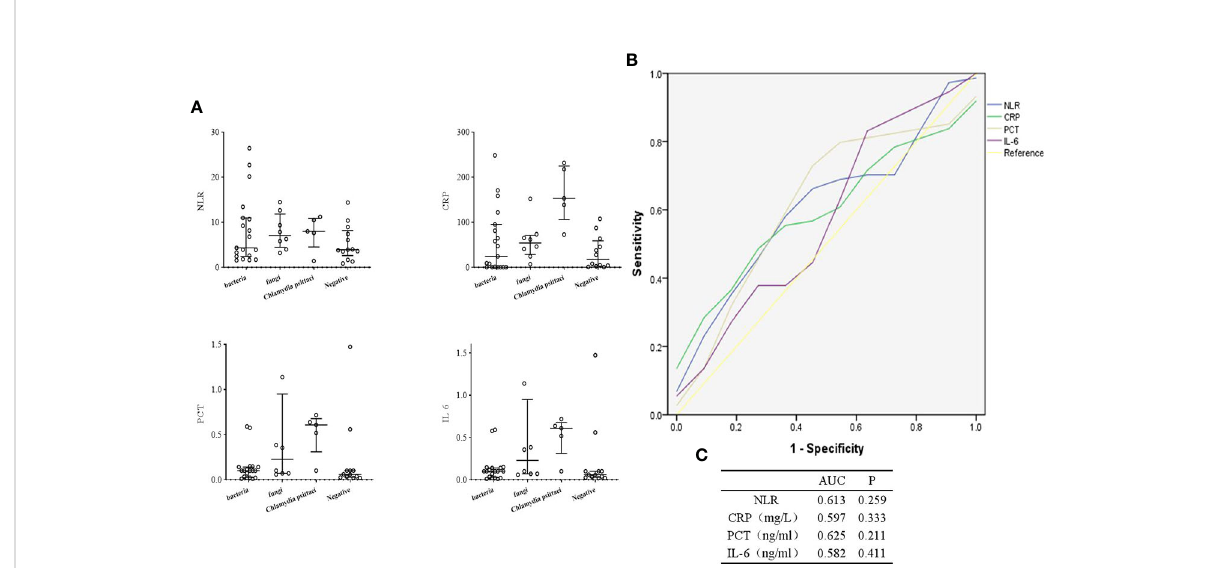
FIGURE 7 Diagnostic value of in fl ammatory indicators in culture-negative BALF of suspected CAP patients. (A) , Comparison of in fl ammatory markers in different types of pathogenic infection. (B, C) , ROC curves for in fl ammatory indicators. NLR, Neutrophil to lymphocyte count